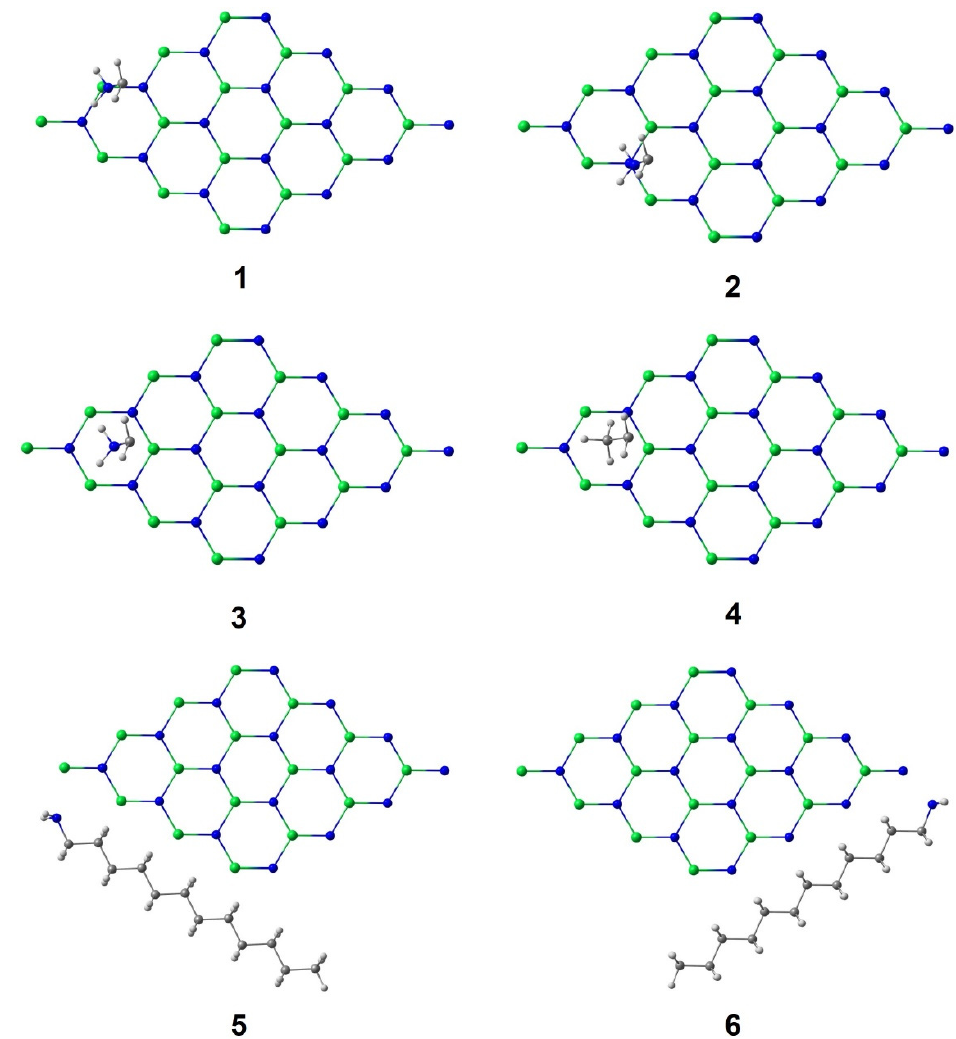
Figure 2. Structures selected for interactions between the surfactant and the sheet. Green: Ga/In. Blue: N. White: H. Grey: C. Table 1. The energy of interaction associated with each binding site is shown in Figure 2.